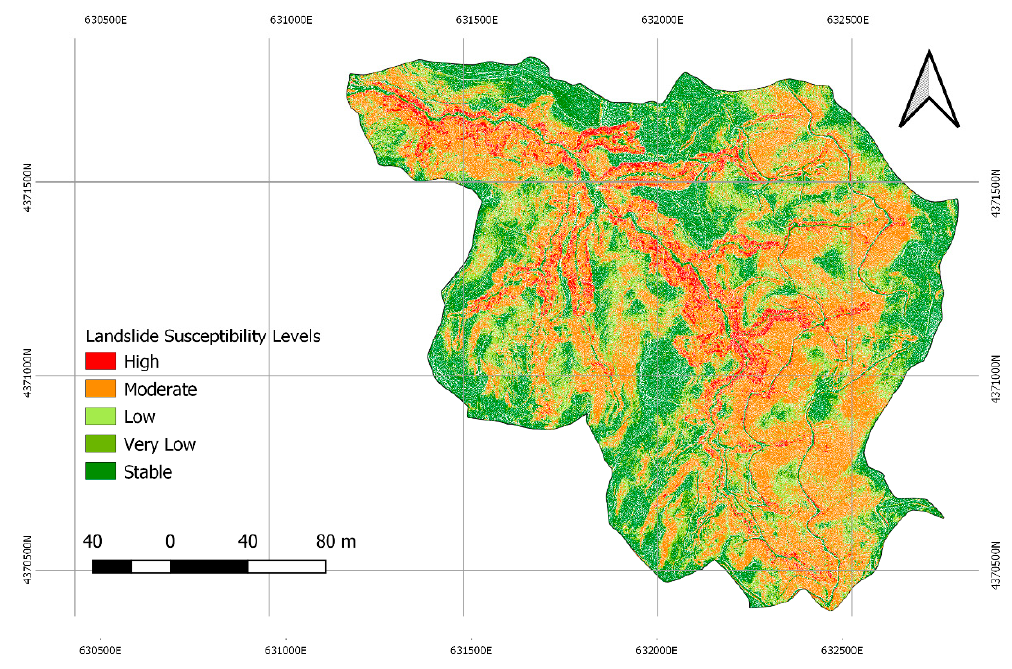
Figure 9. Map of landslide susceptibility without benefit of the vegetation.